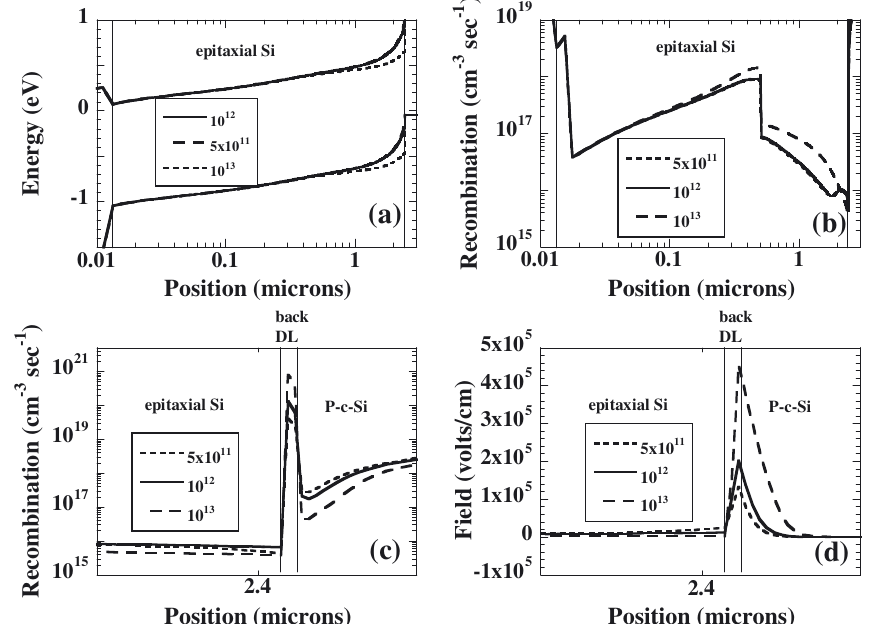
Fig. 8. (a) The energy band diagram, (b) the recombination over the epi-Si layer and (c) around the back interface region; and (d) the electric field over the latter region for the 2.4 μ m epi-Si layer cell under AM1.5 light and short-circuit conditions with the defect density at the epi-Si/P-c-Si interface as a